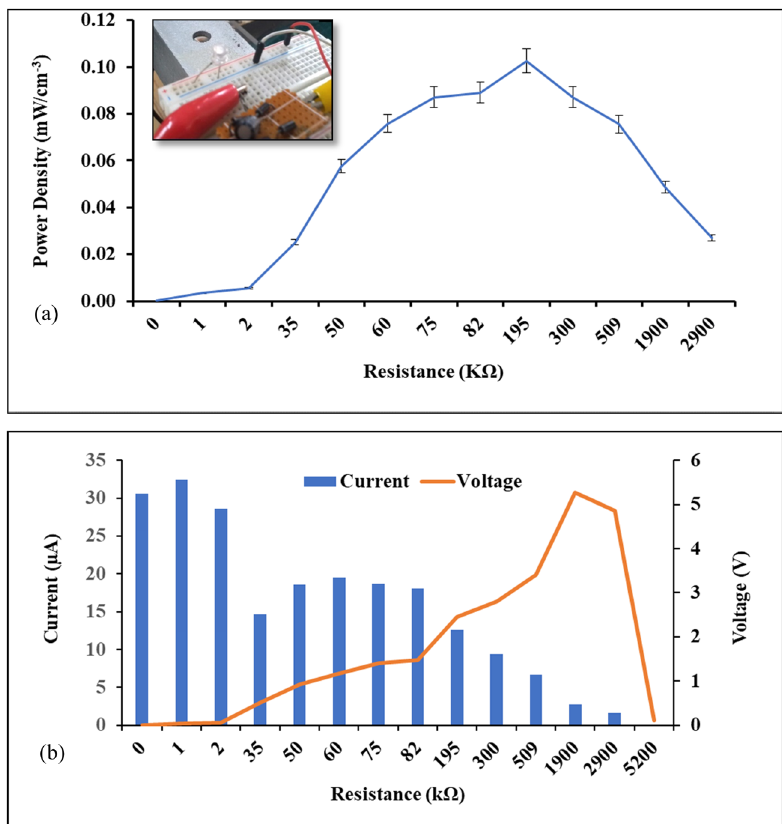
Figure 13: Harvesting energy over cantilever: ( a ) the power density of ZnO NSs – NTO that induces light up of LED diode; ( b ) DC voltage and